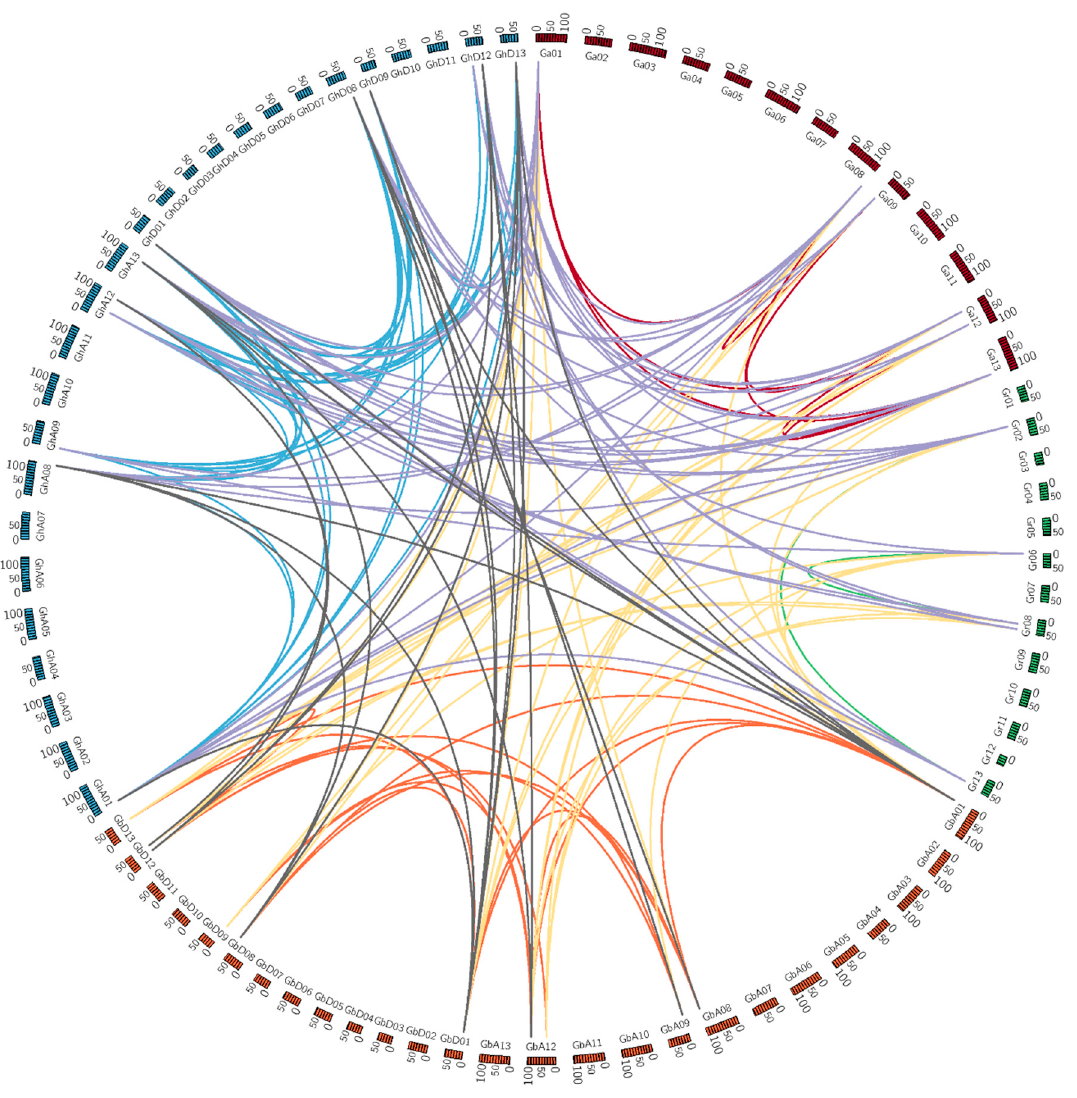
Figure 6. Collinearity of PEPC genes within and between diploid G. arboretum , G. raimondii and tetraploid G. hirsutum and G. barbadense .